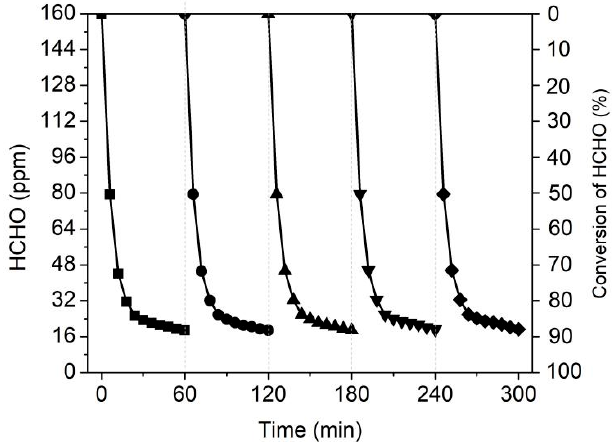
Figure 9. Cyclic performance test of 0.05MnC − 30 − 500 for HCHO removal.